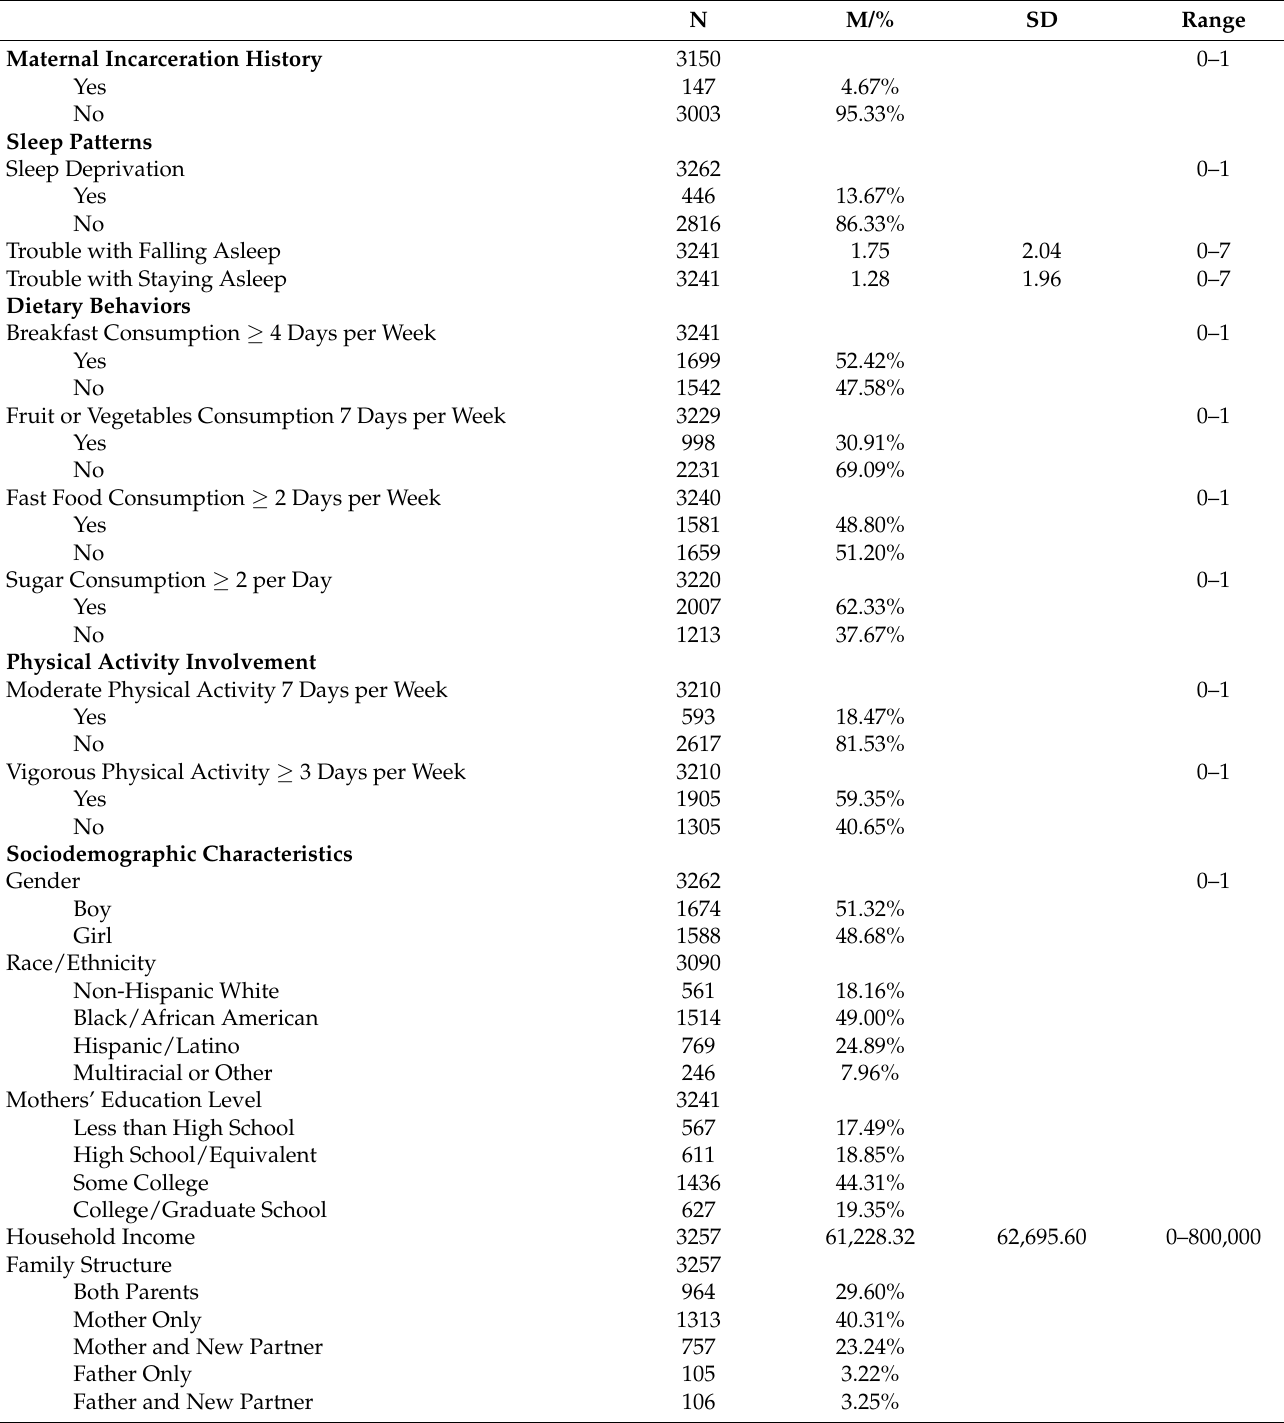
Table 1. Descriptive statistics of adolescents in the study sample, FFCW (N =